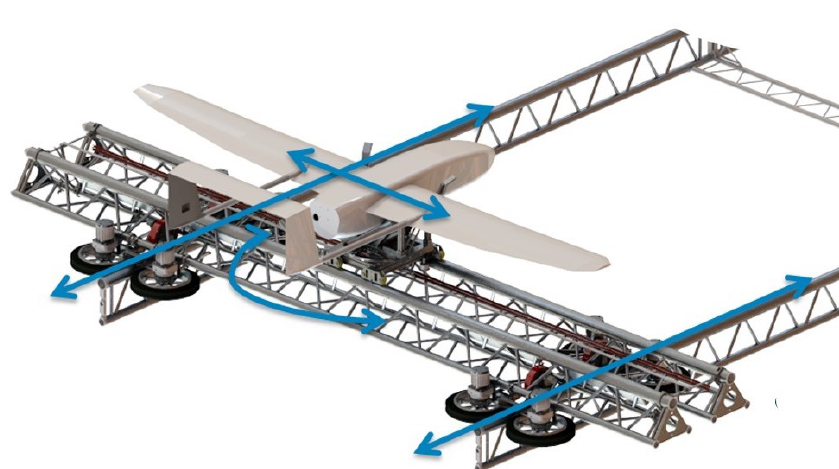
Figure 2. An ElektRail prototype.